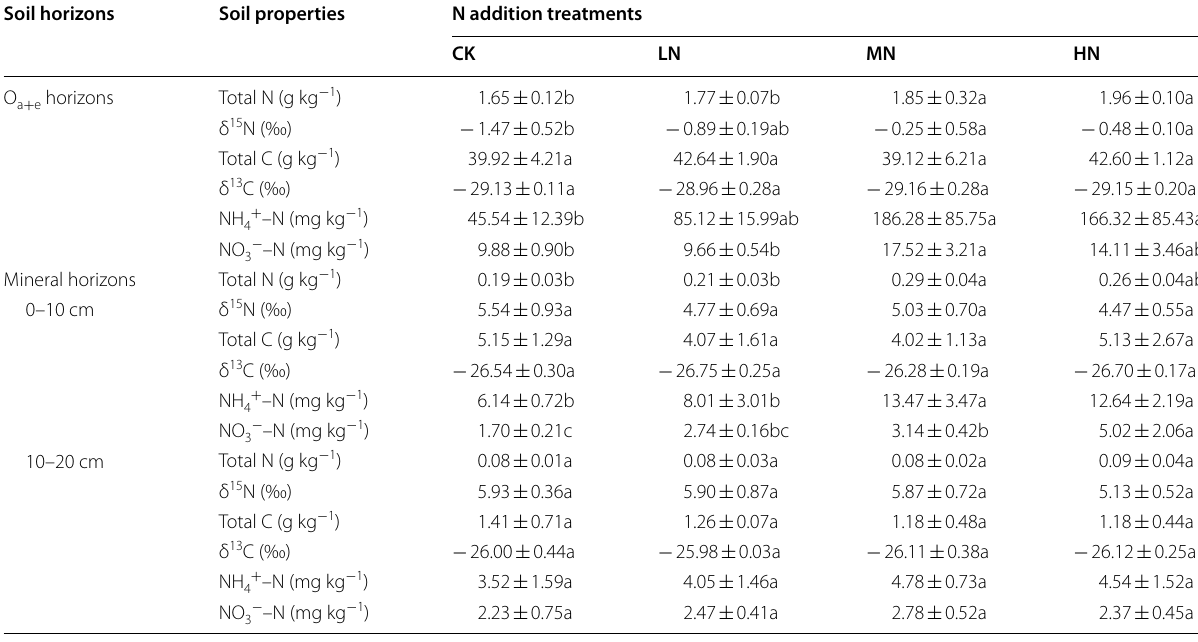
Table 1 Soil N concentrations, δ 15 N values, C concentrations, δ 13 C in the O treatments